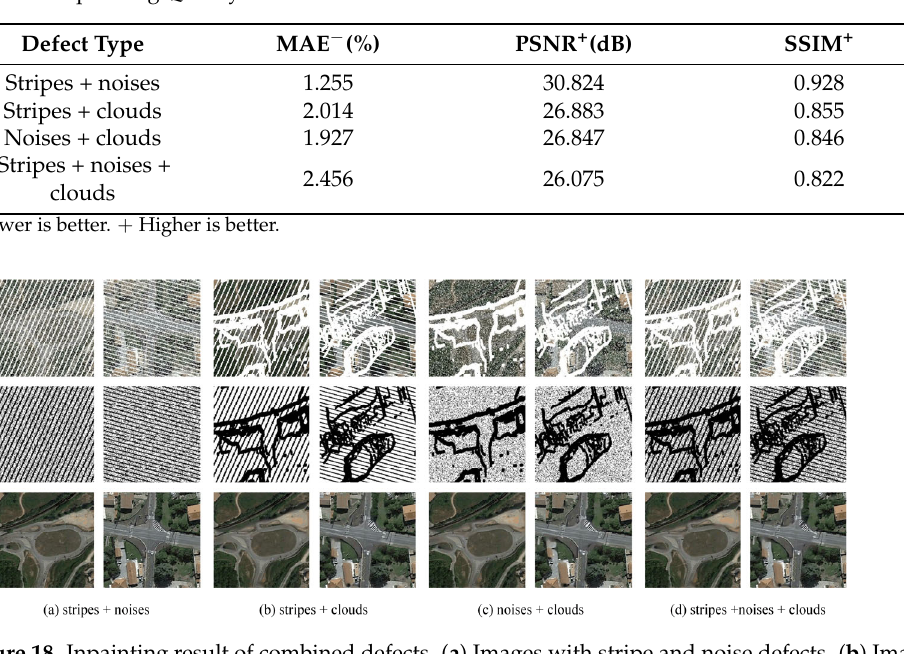
Figure 18. Inpainting result of combined defects. ( a ) Images with stripe and noise defects. ( b ) Images with stripe and cloud defects. ( c ) Images with noise and cloud defects. ( d ) Images with all these three kinds of defects.